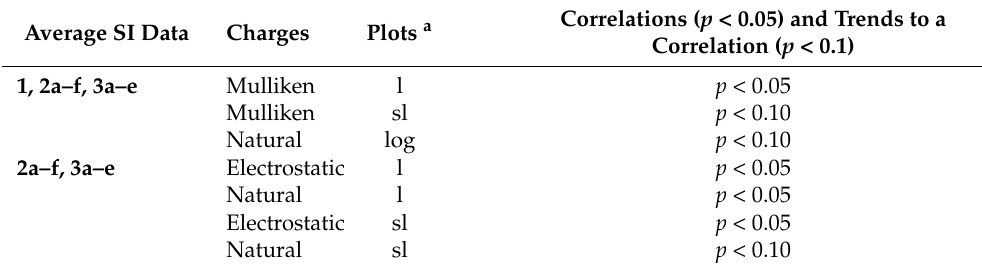
Table 5. Plots between the average SI values in Tables 1 and 2 and the differences between the atomic charges on C A and C B .